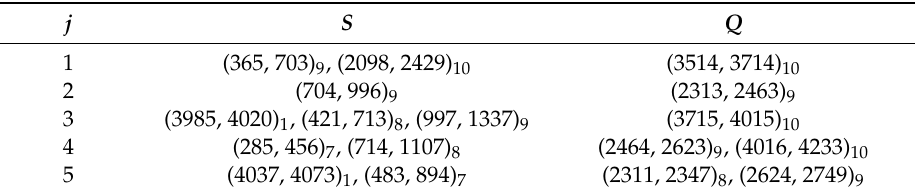
Table 6. Sequence of observation and data-downlink.